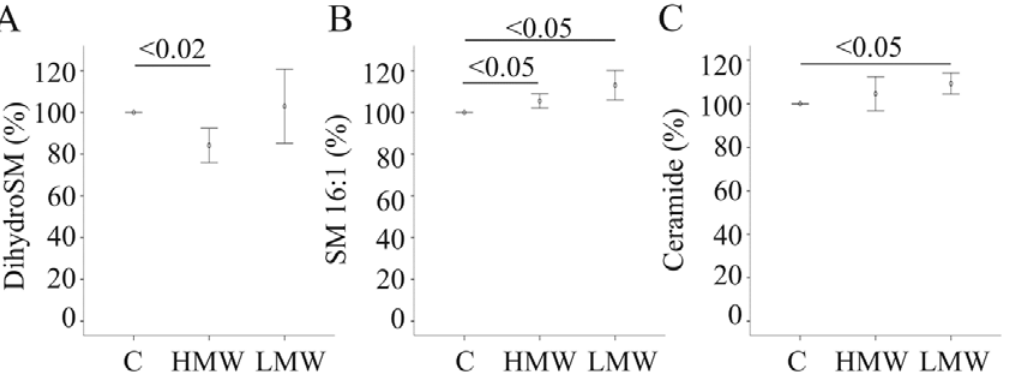
ceramide (Cer). ( A ) Dihydrosphingomyelin (dihydroSM) in cell lysates of PHH of